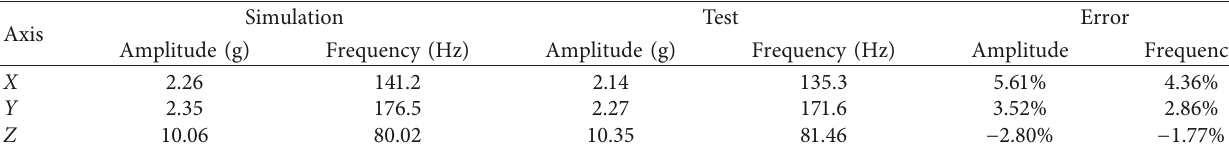
Figure 15: Frequency response test setup. (a) Measurement point arrangement in X and Y directions. (b) Measurement point arrangement in Z Table 7: Comparison of sine sweep resonance frequency and its response value.